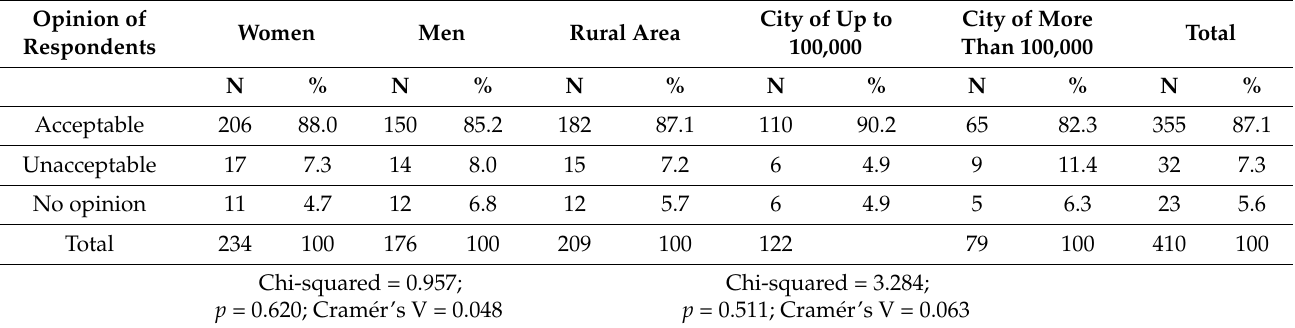
Table 1. Opinions on the acceptability of living together in